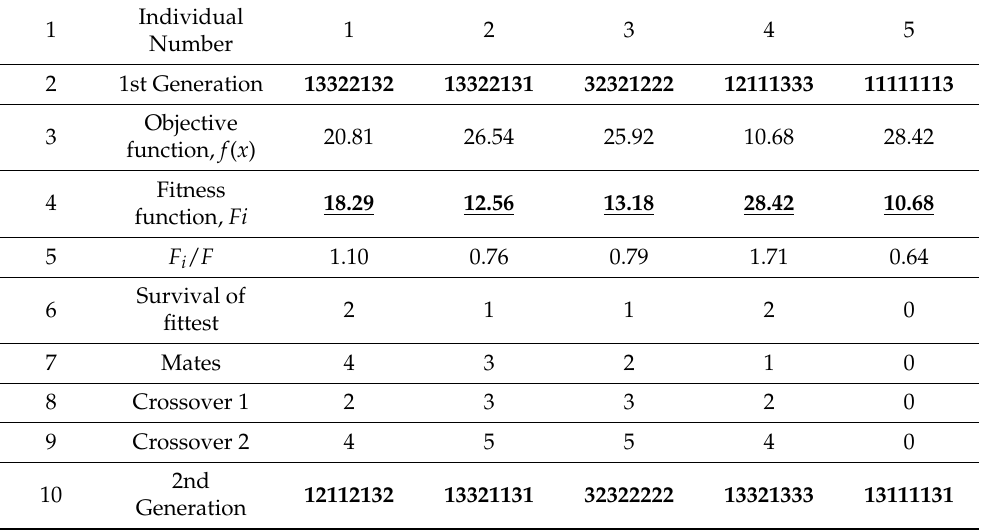
Table 5. Genetic Algorithm Analysis of First Generation and Birth of Second